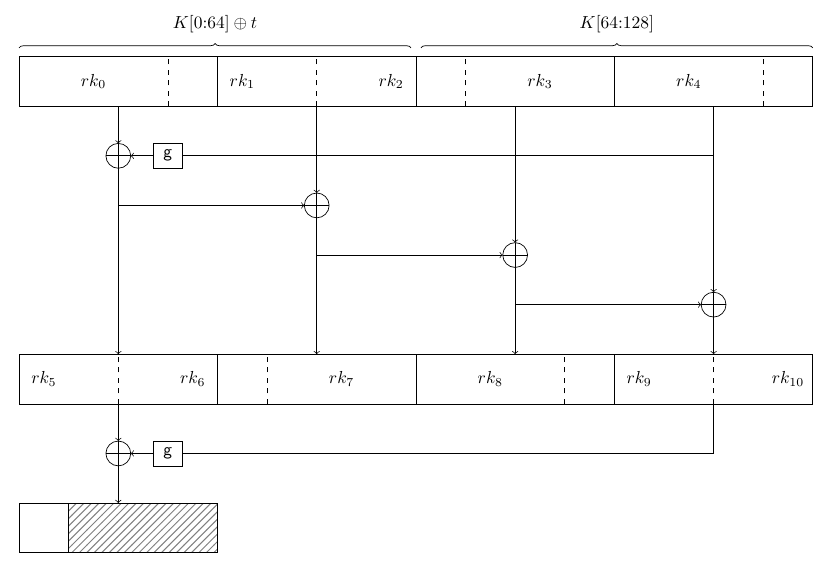
Figure 1: HALFLOOP-24 Key